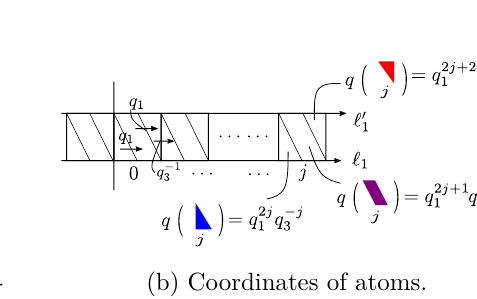
(b) Coordinates of atoms.